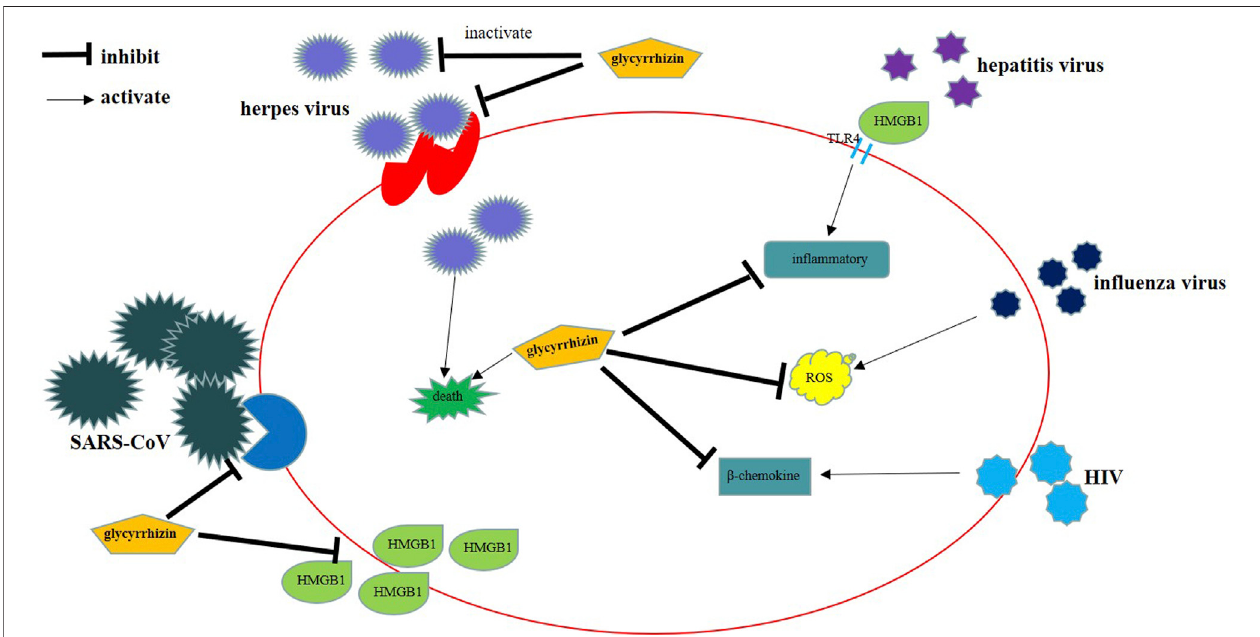
FIGURE 2 | The mechanisms of action of glycyrrhizin against